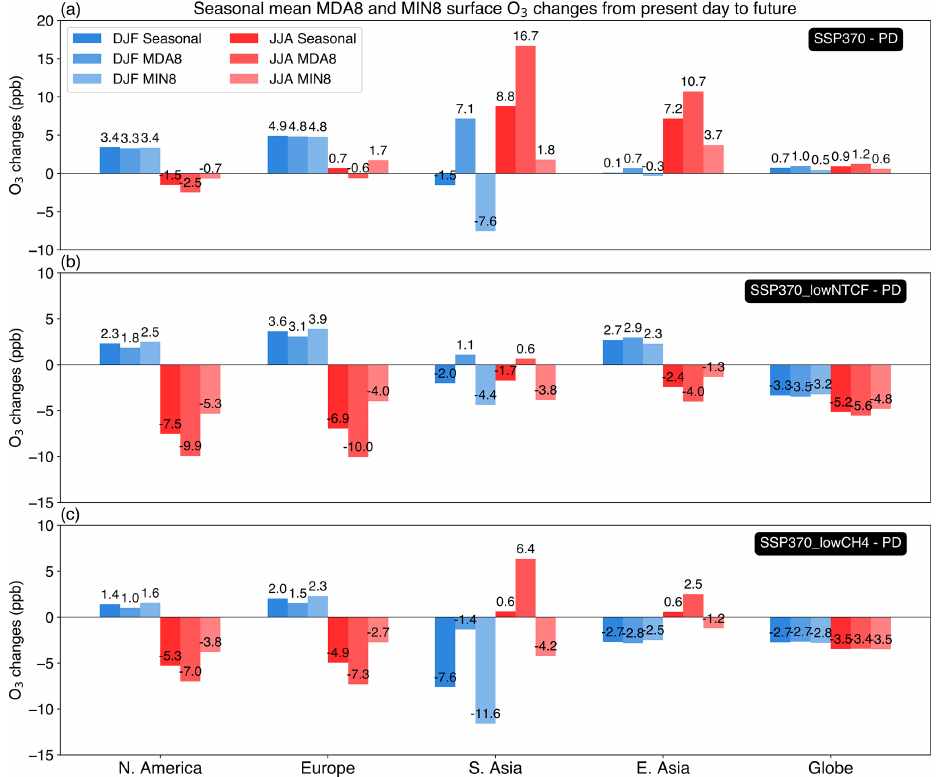
Figure 5. Seasonal mean maximum daily average 8h (MDA8) and minimum daily average 8h (MIN8) surface O 3 changes for North America, Europe, South Asia, East Asia, and the globe from the present day (PD; 2004–2014) to SSP3-7.0 (a) , SSP3-7.0-lowNTCF (b) , and